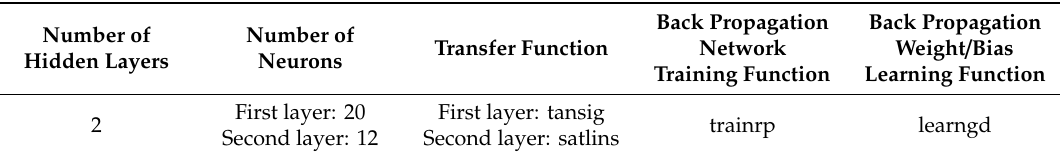
Table 4. The optimized parameters for classification using the hybrid artificial neural network bee algorithm (ANN-BA).